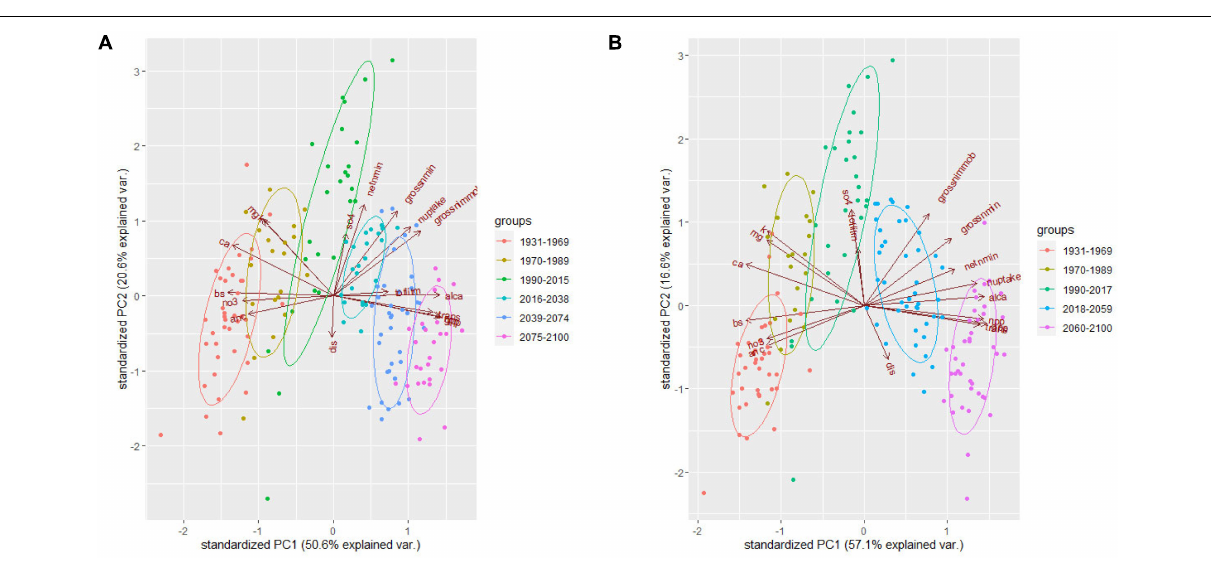
FIGURE 4 | Principal component analysis (PCA) for the 17 variables at WS27 under RCP4.5 (A) and RCP8.5 (B) . trans, transpiration; alca, ratio of Al and Ca in soil; gpp, gross primary productivity; npp, net primary productivity; nuptake, nitrogen uptake by vegetation; netnmin, net mineralization rate of nitrogen; grossnmin, gross mineralization rate of nitrogen; SO4, sulfate concentration in stream; dis, stream discharge; grossnimmob, gross immobilization rate of nitrogen; k, potassium concentration in stream; anc, acid neutralizing capacity; ca, calcium concentration in stream; mg, magnesium concentration in stream; bs, base saturation in soil; no3, nitrate concentration in stream; totlitm, total litter